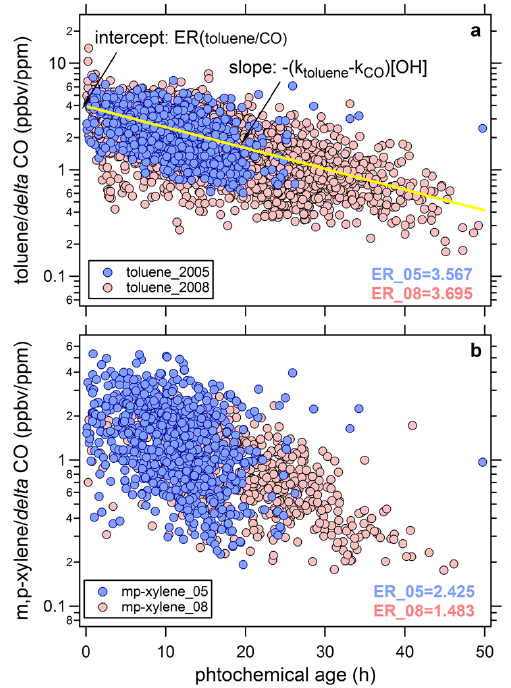
Figure 4. The ratios of toluene/CO (a) and m,p-xylene/CO (b) vs. the photochemical age of the sampled air mass in Beijing for August 2008 (pink) and August 2005 (blue).